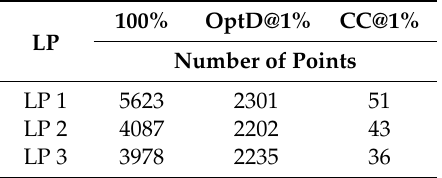
Table 4. E ff ect of data reduction on points in the surrounding area of a Table 4. Effect of data reduction on points in the surrounding area of a LP.